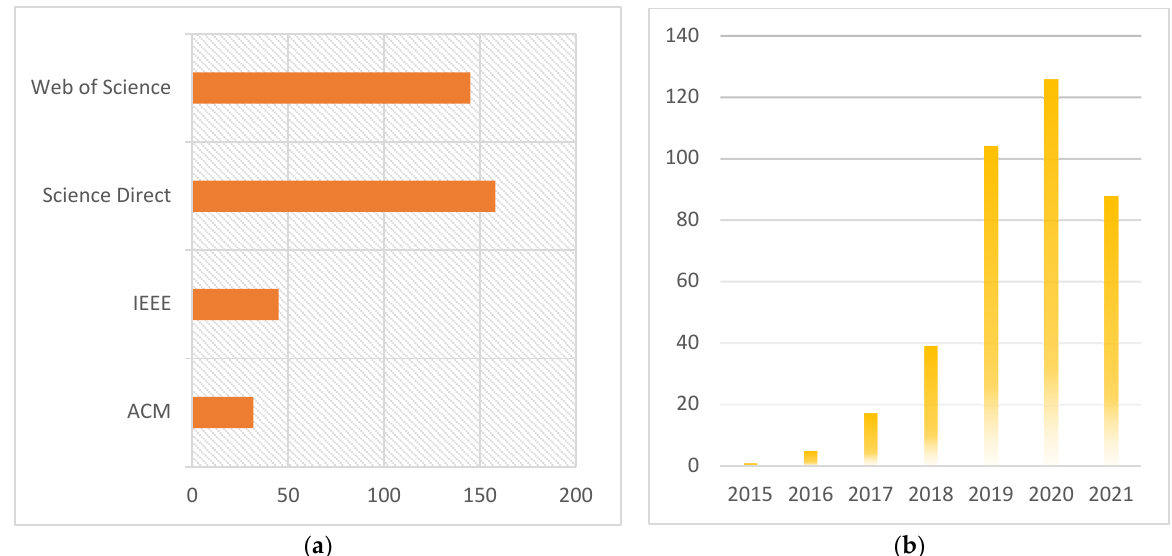
Figure 3. ( a ) Breakdown of recent research publications on DR analysis using deep learning in different databases; ( b ) Year-wise breakdown of recent research publications on DR analysis using deep learning.